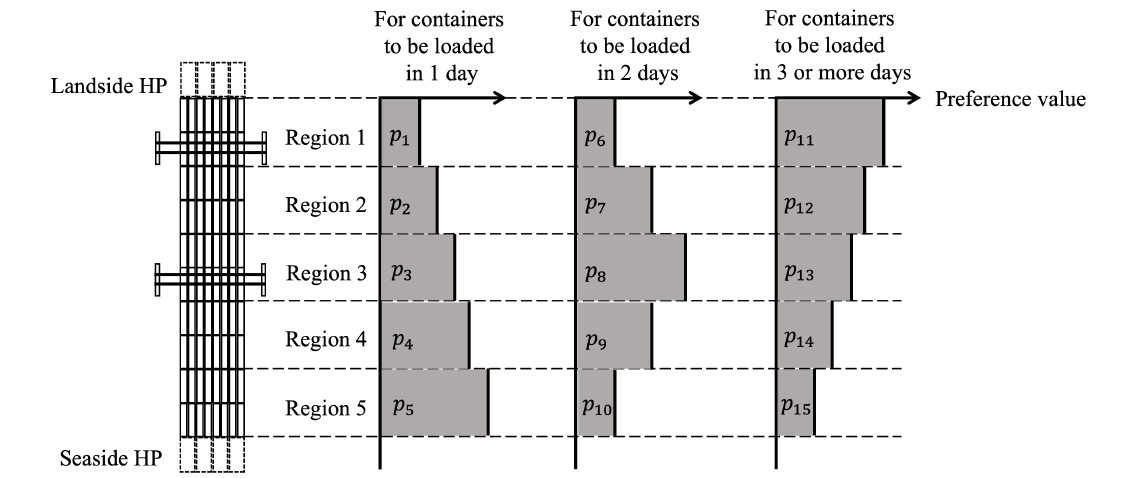
Figure 3. An example of preference distributions over the stacking regions within a block for the outbound containers with different loading times.